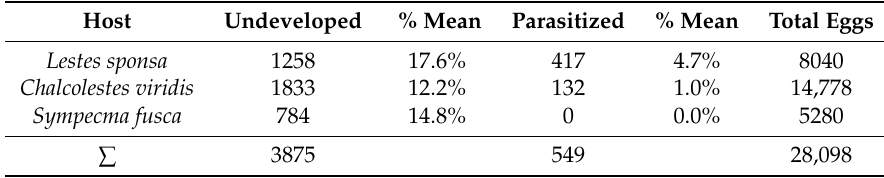
Table 3. The total number of lestid eggs excised from plant tissues and the proportion of undeveloped/parasitized eggs.